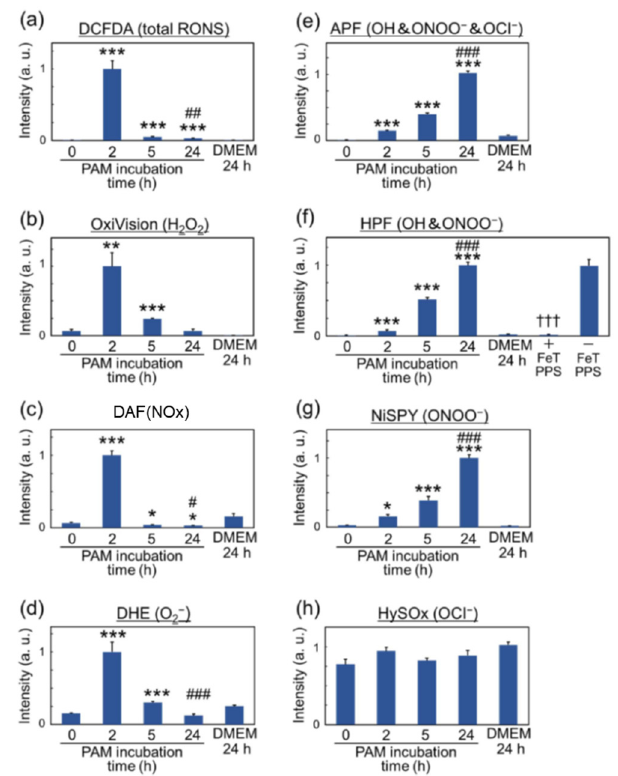
Figure 3. Intracellular reactive oxygen and nitrogen species (ROS/RNS) dynamics in Plasma-Treated Solution (PTS)-exposed HeLa cells. ( a ) total RONS determined using CM-H2DCFDA fluorescent stain reagent; ( b ) H 2 O 2 determined using OxiVision fluorescent stain reagent; ( c ) • NO determined using DAF-FM-DA fluorescent stain reagent; ( d ) • O 2 − determined using DHE fluorescent stain reagent; ( e ) • OH, ONOO − , and OCl − determined using APF fluorescent stain reagent; ( f ) • OH and ONOO − determined using HPF fluorescent stain reagent; ( g ) ONOO − determined using NiSPY-3 fluorescent stain reagent; ( h ) OCl − determined treatment using HySOx fluorescent stain reagent. The symbols * and # indicate significant differences between PAM and nontreatment and between PAM and 24 h DMEM treatment. One symbol; p < 0.05, double symbols; p < 0.01, triple symbols; p < 0.005. Modified from [60]. Copyright 2017 Wiley.